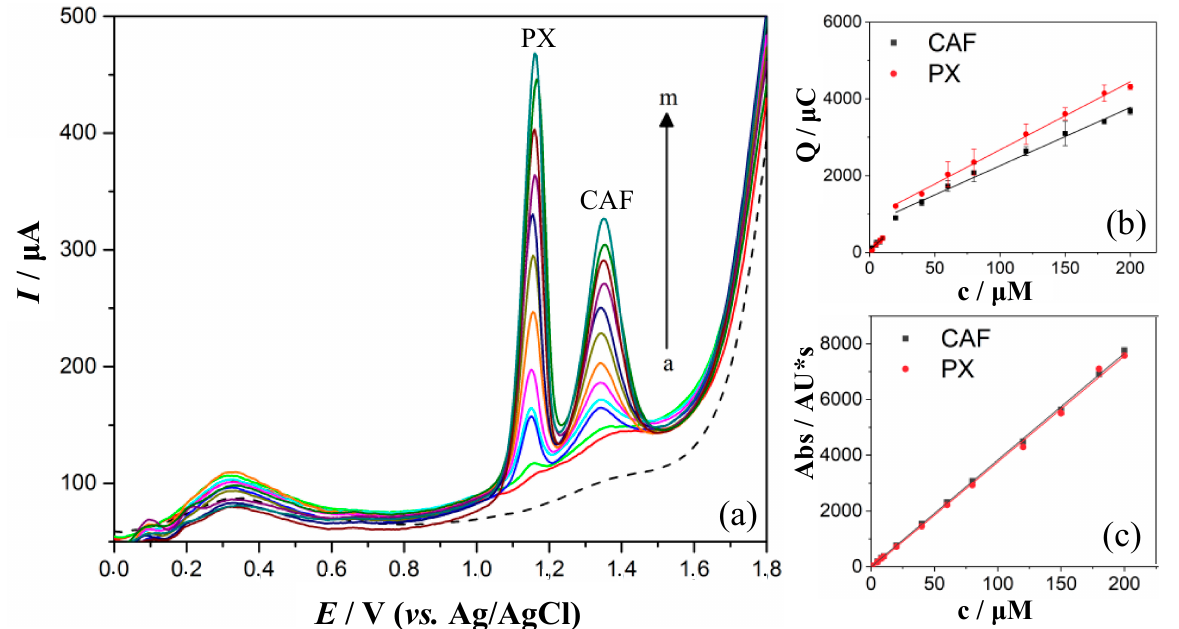
Figure 4. ( a ) DP voltammograms of equimolar mixtures of paraxanthine (PX, E PX = +1.15 V) and caffeine (CAF, E CAF = +1.36 V): blank, 1, 2, 5, 8, 20, 40, 60, 80, 120, 150, 180 and 200 µ M in 0.1 M H 2 SO 4 on the GC electrode at a scan rate of 5 mV s − 1 ; corresponding calibration curves by ( b ) differential pulse voltammetry (DPV) and ( c ) UHPLC-UV.